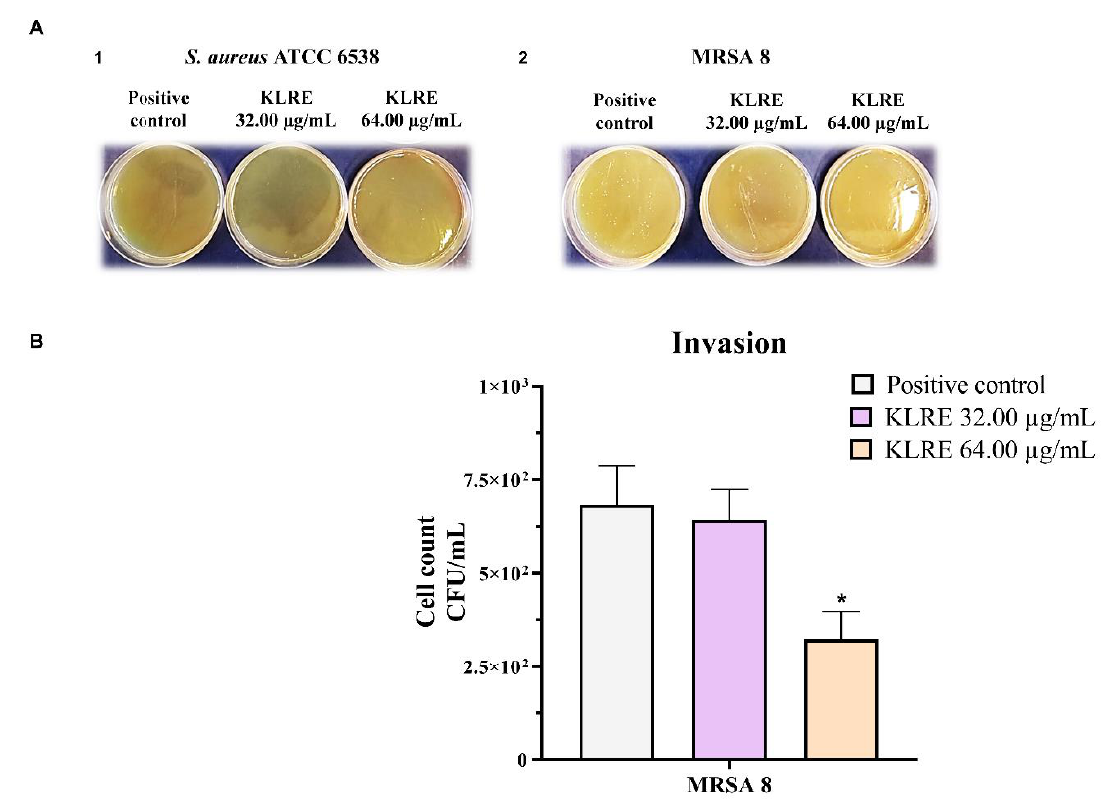
Figure 7. Effect of K. lappacea root extract (KLRE) on the invasion of S. aureus ATCC 6538 and MRSA 8 to human lung A549 cell line. ( A 1, A 2). Representative photographs of plate bacterial count. ( B ). Quantitative analysis of bacterial invasion to A549 cells. Light grey histogram: A549 cells infected with MRSA 8 strain (positive control). Violet histogram: A549 cells infected with MRSA 8 and simultaneously treated with 32.00 µ g/mL of KLRE. Pink histogram: A549 cells infected with MRSA 8 and simultaneously treated with 64.00 µ g/mL of KLRE. The values are expressed as colony-forming unit mL − 1 (CFU/mL). The bars represent means ± SD of three independent experiments performed in triplicate (SD = standard deviation). Statistically significant differences, determined by one-way analysis of variance (ANOVA), are indicated: * p ≤ 0.05, § p ≤ 0.0001 versus positive control.